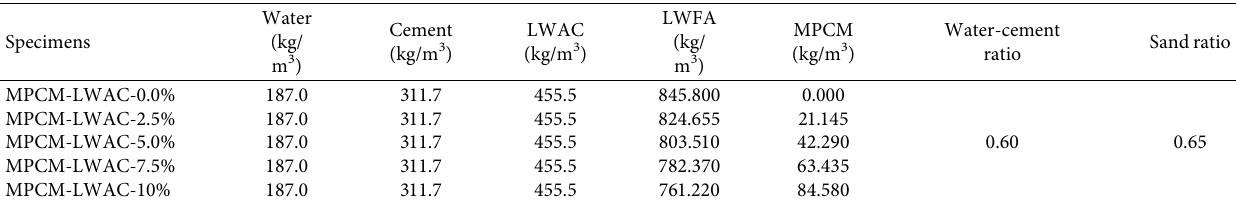
Table 4: Mix proportion of MPCM-LWAC specimens by using the method of equal mass